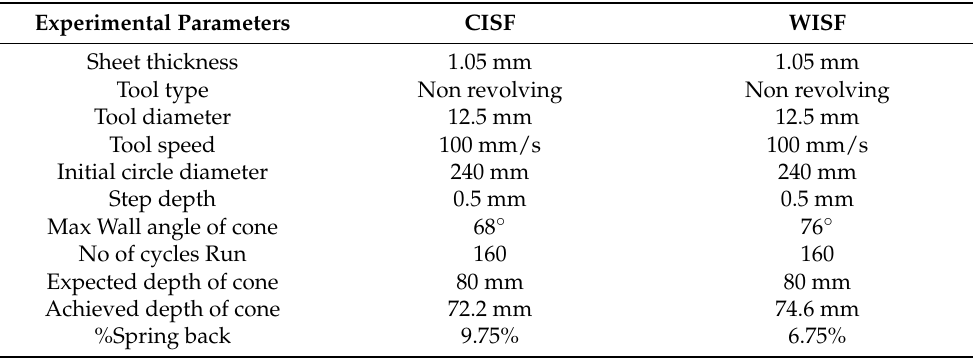
Figure 8. Various successfully made shapes on the existing machine of RAISF: ( a ) straight groove, ( b ) conical shape, ( c ) multi-stage conical shape, ( d ) square pyramid, and ( e ) multi feature shape. For comparison of formability, a fixed wall angle cone was formed until the onset of fracture. The maximum wall angle achieved in the case of CISF was 68° in single-stage forming and 76° for WISF in single-stage forming. The details of the geometry along with the experimental conditions are summarized in Table 5. Table 5. Experimental details for CISF and WISF.